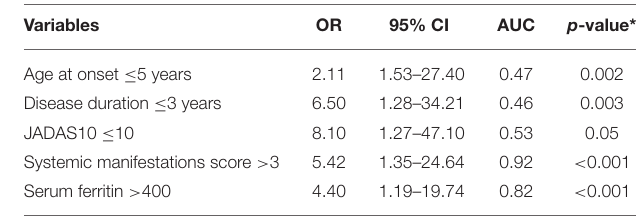
TABLE 5 | Logistic regression of predictors for effective response to tocilizumab therapy.